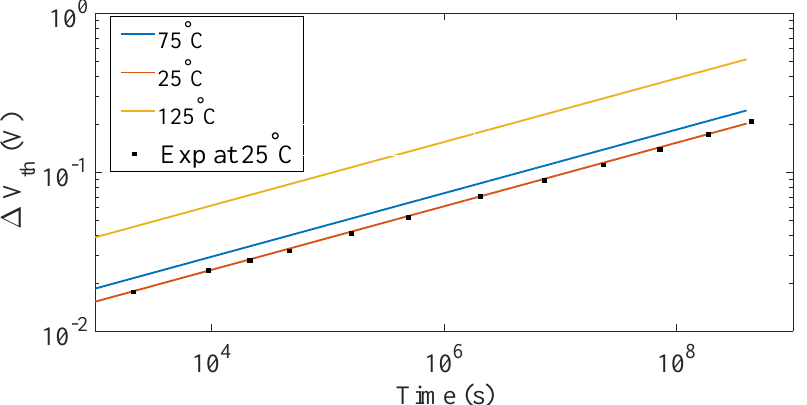
Figure 13. PBTI model results compared to the measured data for the InGaAs to Al 2 O 3 interface in log